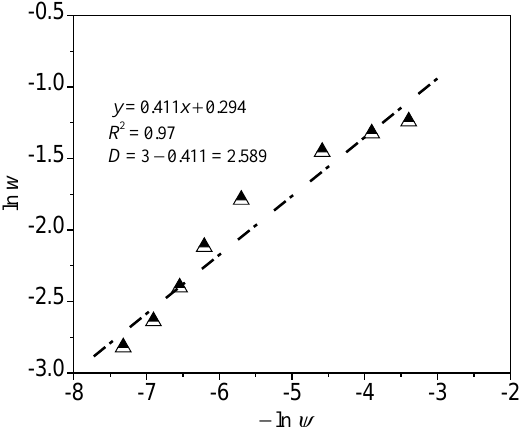
Figure 9. Determination of the values of fractal dimension at reference state through plotting experimental data of ln w against ( − ln ψ ) for Guangxi expansive soil with e 0 = 0.901.